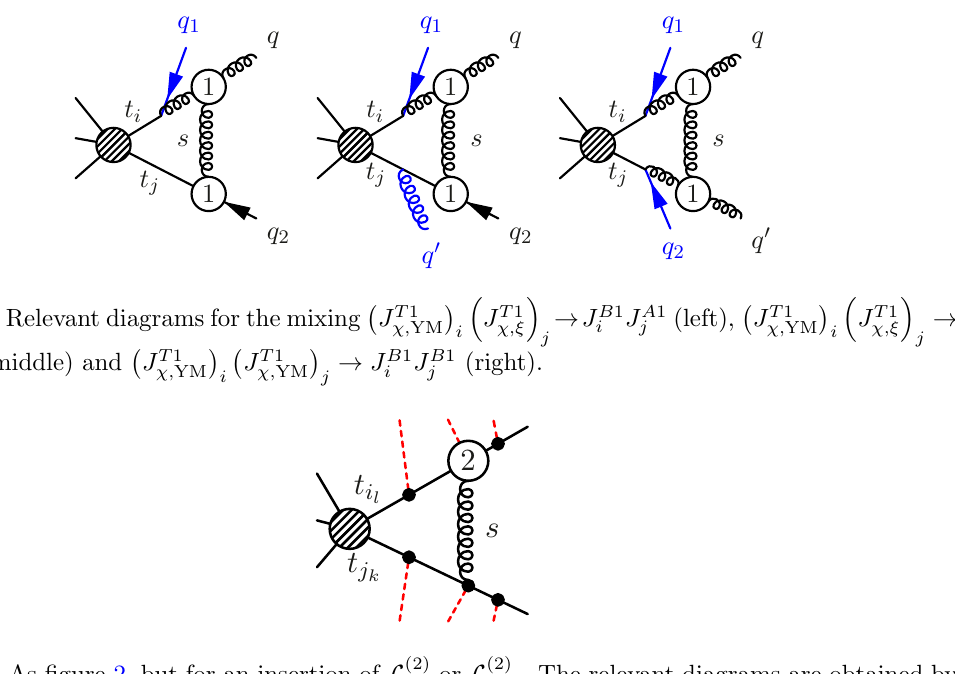
(cid:0) J T 1 (cid:31); YM